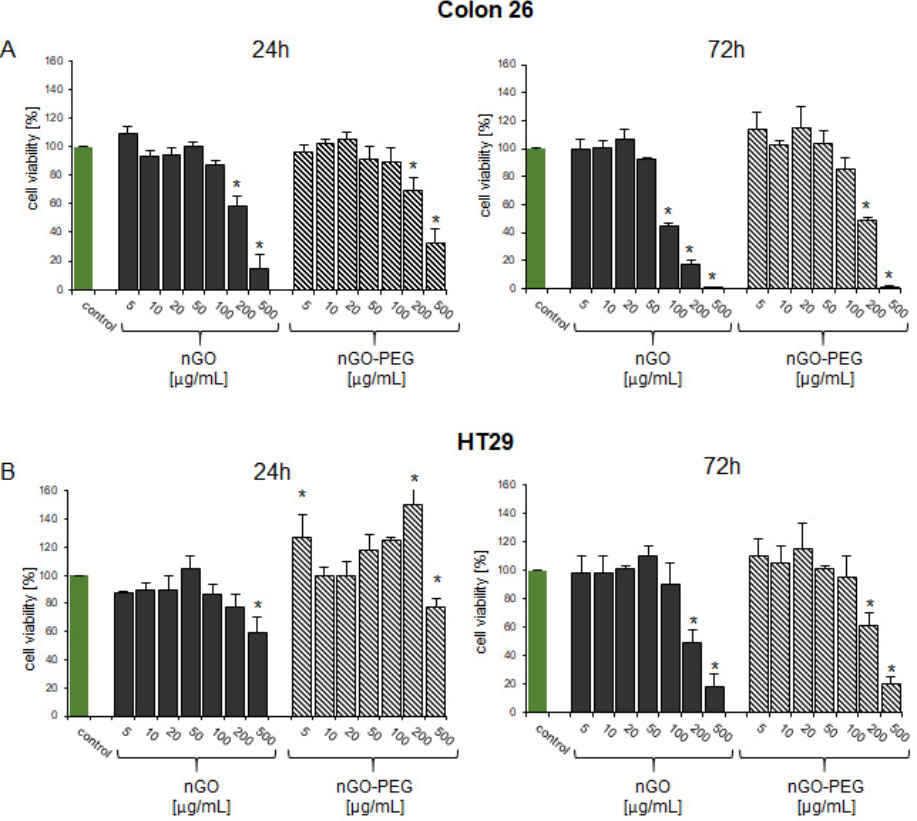
Figure 5. Biocompatibility and cytotoxicity of nGO and nGO-PEG nanoparticles (NPs). ( A ): WST-1 assay after treatment of Colon26 cells with nGO and nGO-PEG with increasing concentrations for 24 h and 72 h. ( B ): WST-1 assay after treatment of HT29 cells with nGO and nGO-PEG with increasing concentrations for 24 h and 72 h. Three repetitions of the experiments are done an values are MEAN ± STDV. Statistical analysis is represented as *, where * p < 0.05 is accepted as statistically significant.